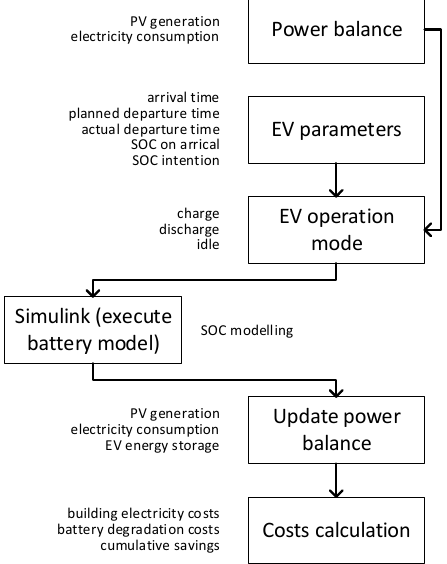
Figure 4. The sections of the MATLAB model.